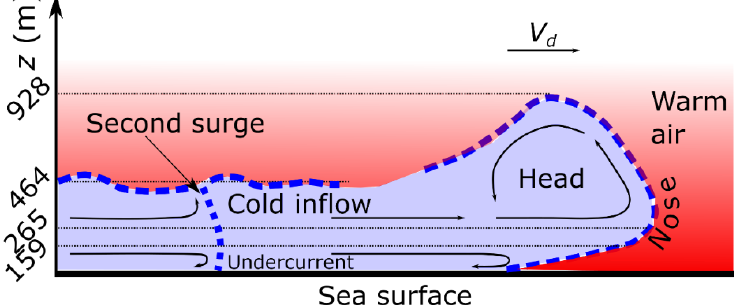
Figure 15. Conceptual model of the gust front that occurred prior to the collapse of the Morandi Bridge in Genoa on 14 August 2018. The blue dashed line represents the estimated shape of the gust front. The blue and red colors indicate the regions of cold and warm air, while the black 𝑉 𝑑 arrow shows the direction of gust front propagation. The black arrows within the gust front portray the air movement relative to the front. See text for full interpretation and underlying assumptions.